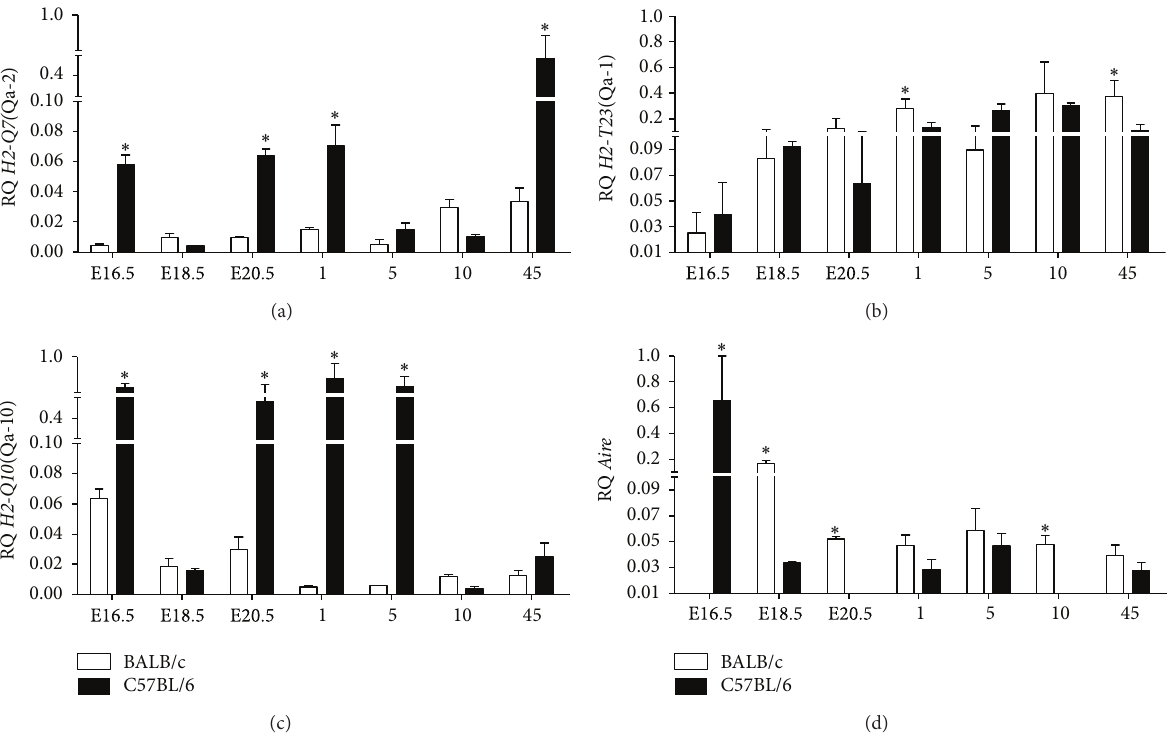
Figure 3: Comparison of gene expression profiles during thymus development between C57BL/6 and BALB/c mice. Relative quantification (RQ) of messenger RNA for (a) H2-Q7 (Qa-2), (b) H2-T23 (Qa-1), (c) H2-Q10 (Qa-10), and (d) Aire is representative of the mean values of 2 −ΔΔ Ct . Tissue samples were obtained in triplicate from different animals and lineages for each age analyzed. Each experiment was independently performed at least three times. Data were analyzed statistically by the Student’s 𝑡 -test. Values close to the level of significance are marked with ( ∗